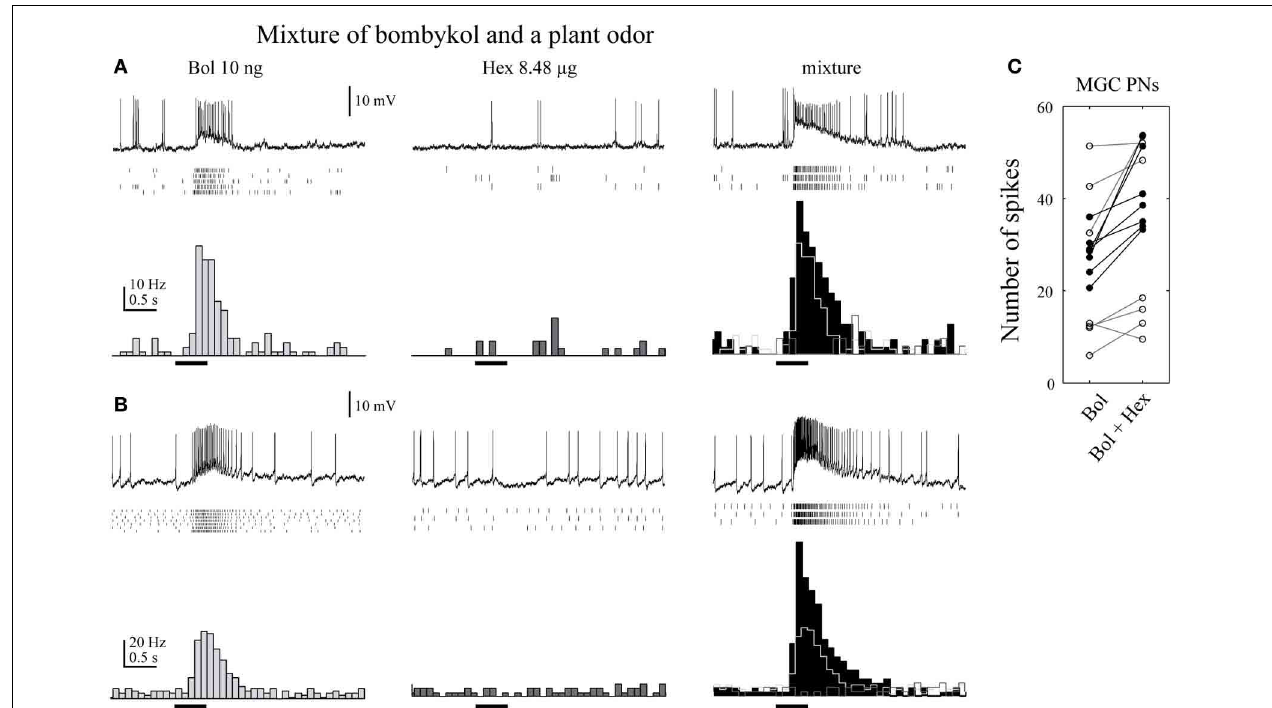
FIGURE 7 | A plant odor enhances the activity of toroid projection neurons in response to bombykol. (A) Physiology of uniglomerular projection neurons innervating the toroid. Raster plots of individual trials (top) and the number of spikes (bottom) are shown. The neurons showed a transient excitatory response to bombykol (Bol), no response to cis -3-hexen-1-ol (Hex), and a transient excitatory response to the